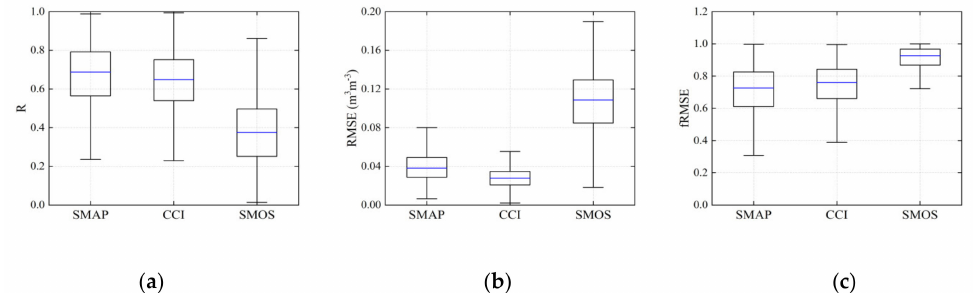
Figure 4. ( a ) Correlation coe ffi cient (R), ( b ) root mean square error (RMSE), and ( c ) fractional RMSE (fRMSE) of Soil Moisture Active Passive (SMAP), Climate Change Initiative (CCI), Soil Moisture and Ocean Salinity (SMOS) soil moisture products based on Triple Collocation (TC). Horizontal lines of the box indicate the 25th percentiles, median, and 75th percentiles, respectively. Whiskers indicate the minimum and maximum